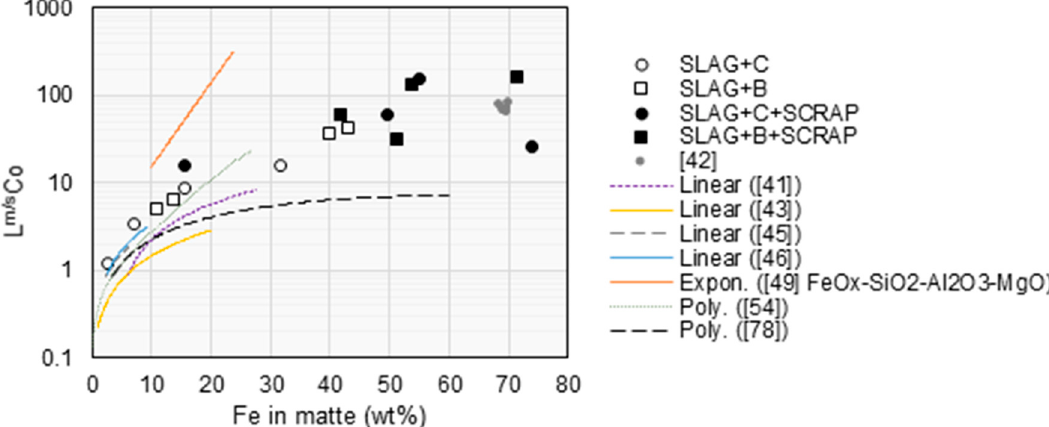
Figure 9. The distribution coefficient of cobalt between matte and slag as a function of decreasing matte grade at 1400 °C. Multiple other equilibrium studies [43,45,46,49,54,78] and kinetic studies by Ruismäki et al. [41,42] were added in the figure.